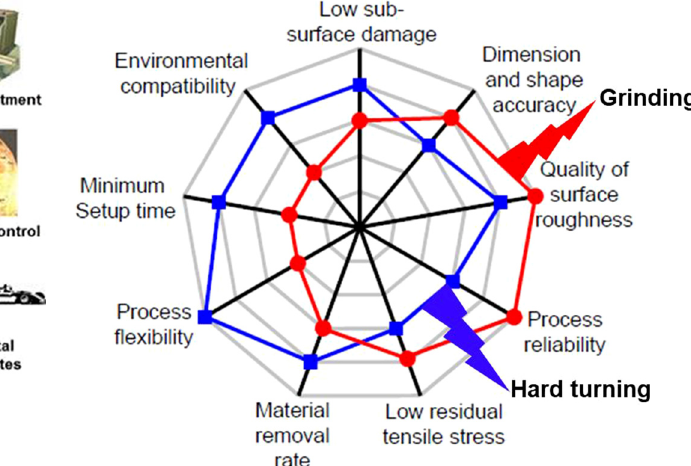
Fig. 2. Qualitative overview of the capability of hard turning and grinding processes [10].